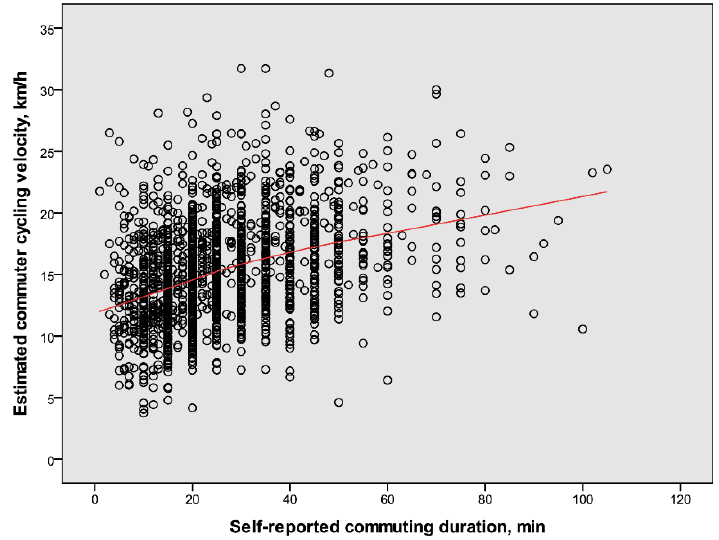
Figure 2. The relation between self-reported durations and estimated velocities for commuter cyclists ( n = 1661, 34% males). The line fits 85% of the individual values.